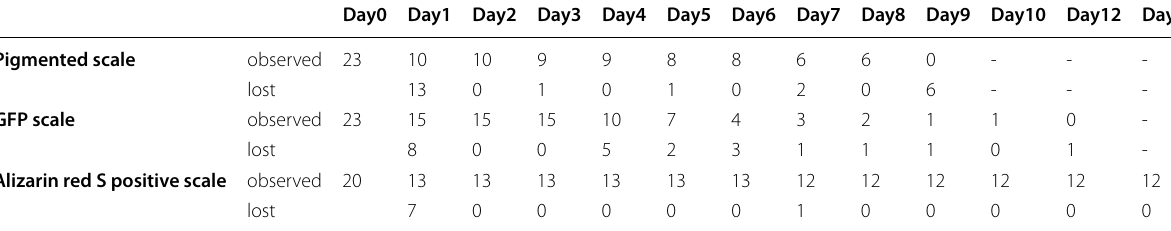
Table 3 Results of scale transplantation into a d‑rR